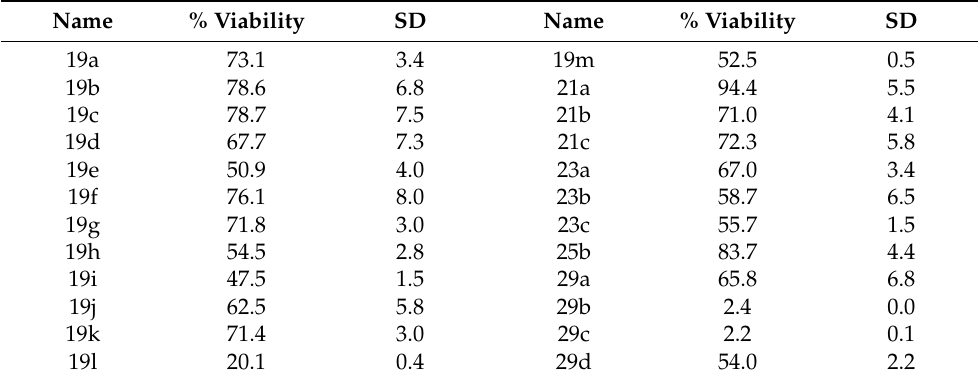
Table 3. Cytotoxicity studies in human HEK293